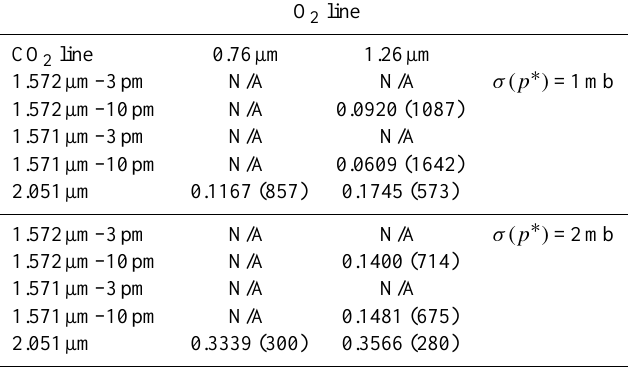
) computed from Eq. (13) expressed as percentages of a representative Table 3. Upper bounds on the O 2 measurement uncertainty σ obs ((cid:49)τ O 2 (cid:49)τ O using 21% atmospheric concentration and a typical vertical WF. The corresponding SNR lower bound is given in parentheses. For 2 example, if the surface pressure error is 1mb, the 0.76µm precision would have to be smaller than 0.1167% in order for the ratio with the strong band CO 2 measurement to provide a better constraint on model CO 2 than the CO 2 measurement alone using NWP p ∗ . The quantity N/A represents the scenarios in which Eq. (13) yielded a negative number, i.e., in which no O 2 instrument precision would yield a larger measurement using NWP p ∗ . than the corresponding (cid:49)τ CO information content on model q CO 2 2 O 2 line